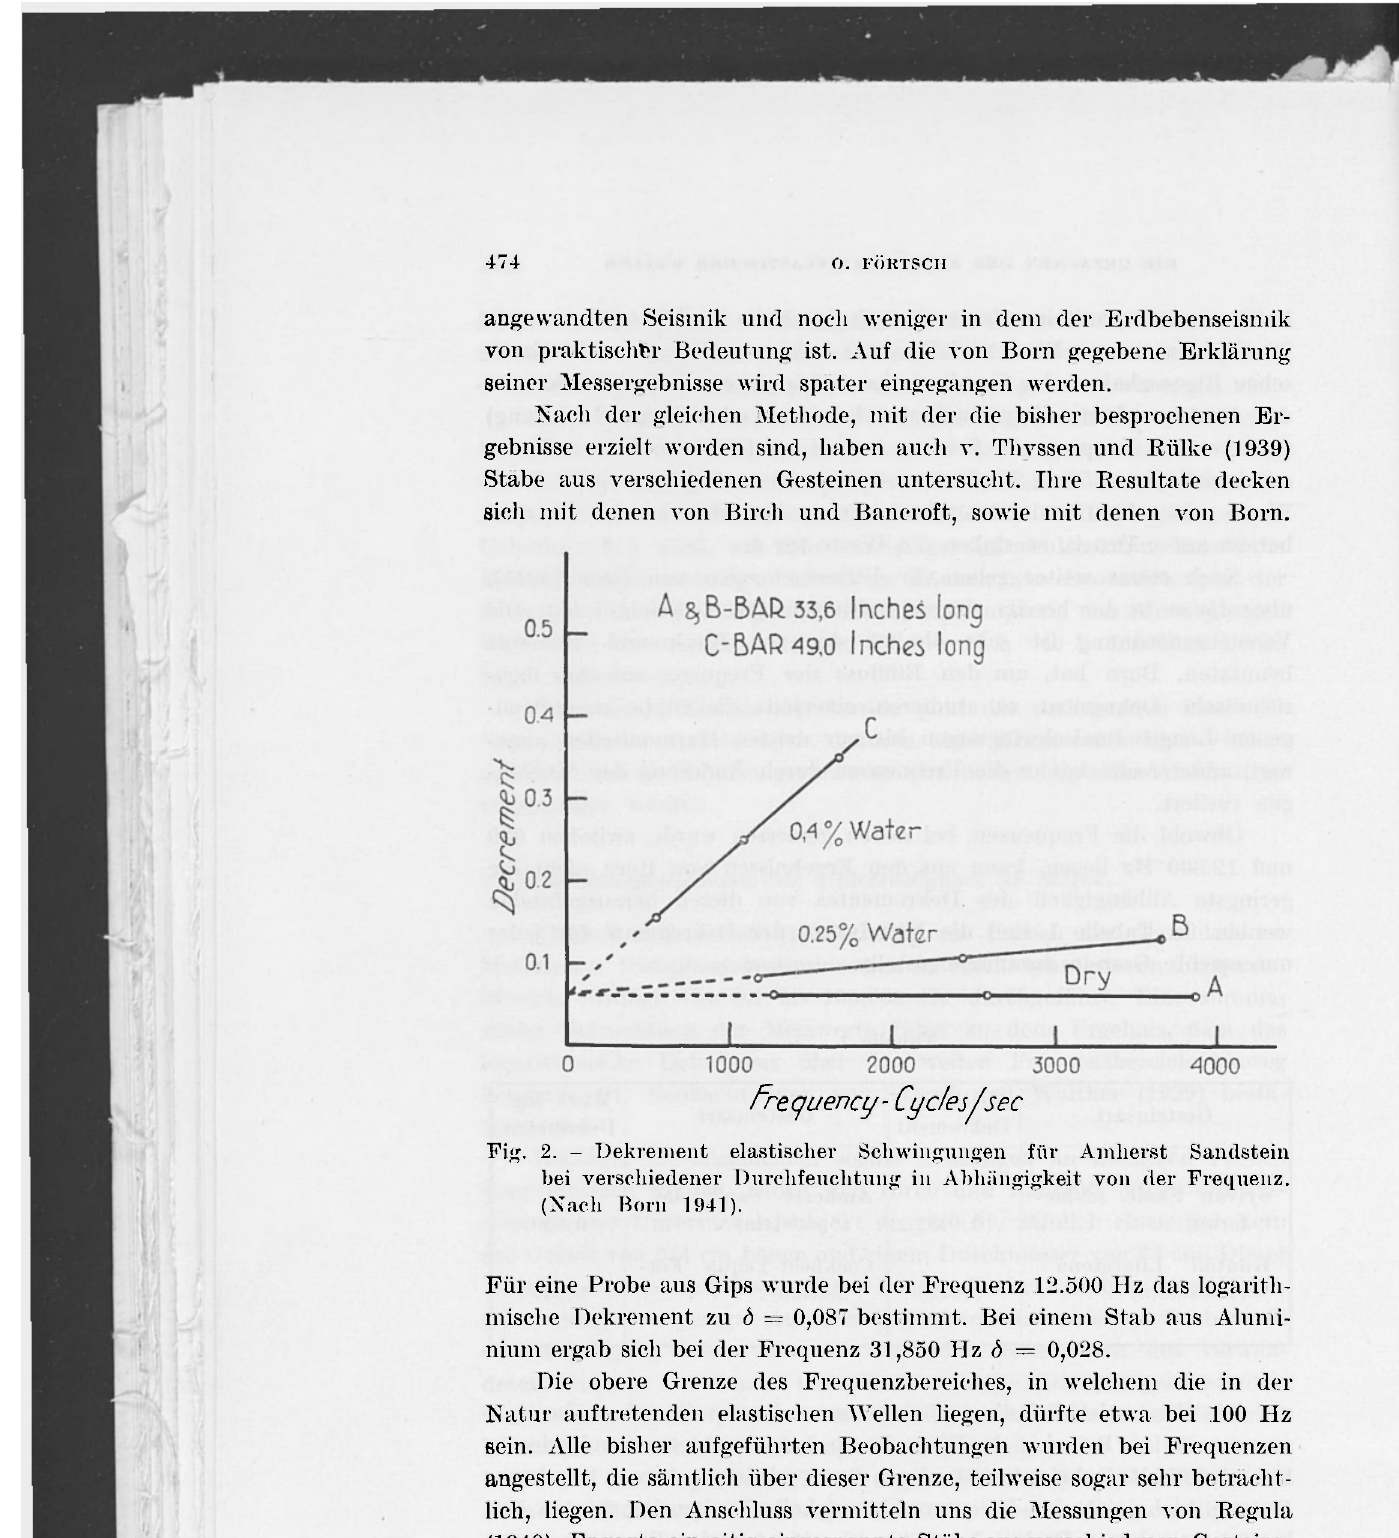
Fig. 2. - Dekrement elastiseher Sehwingungen fiir Amlierst Sandstein bei verschiedener Durchfeuchtung in Abhàngigkeit von dei- Frequenz. (Nach Born